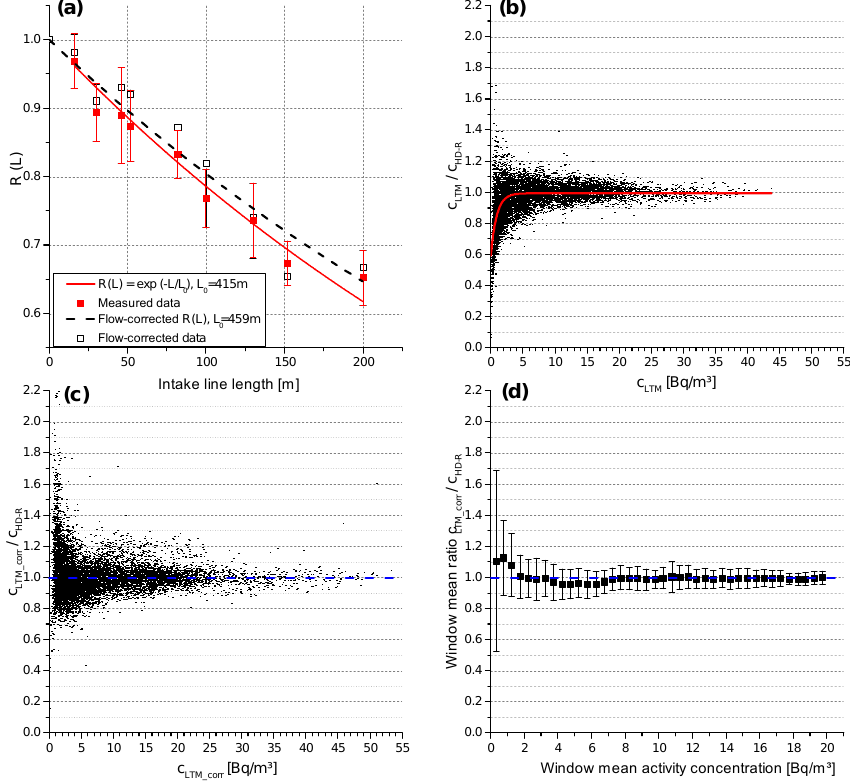
Figure 2. (a) Length-dependent saturation values as determined from individual line tests (compare also Figs. S1–S9 in the Supplement). The solid red line is an exponential fit calculated through all experimental data according to Eq. (2). Black open symbols show experimental values adjusted to a standard flow rate of 1m 3 h − 1 , according to Eqs. (3)–(5), with the dashed black line being the exponential fit through these adjusted data. (b) Length-corrected line test results (i.e. normalized to R = 1) together with the saturation fit curve calculated according to Eq. (1). (c) Activity concentration ratio of corrected LTM data and HD-R data without tubing. Panel (d) gives the standard deviations of ratios displayed in (c) binned into 0.5 Bqm − 3